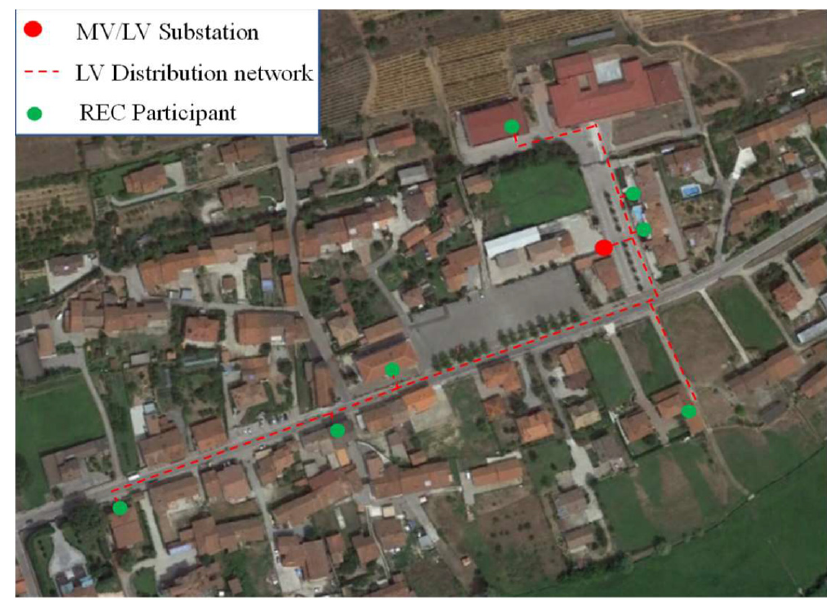
Figure 1. Aerial view of the REC.